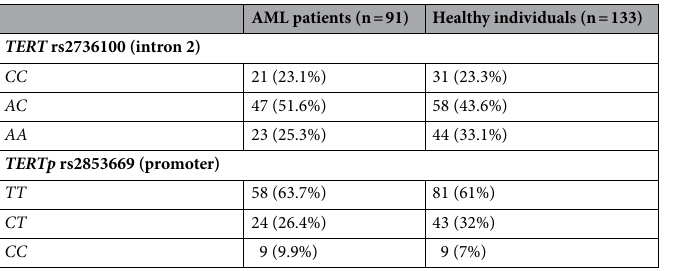
Table 1. Distribution of TERT genotypes in acute myeloid leukaemia (AML) patients and healthy individuals.